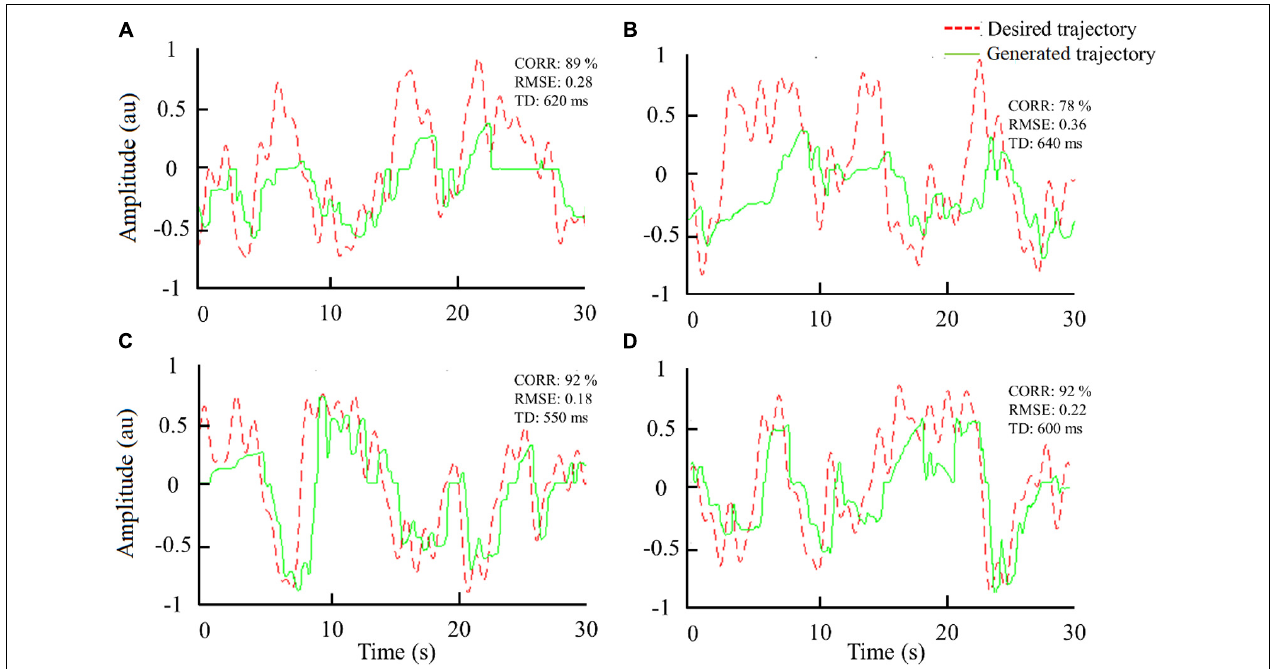
FIGURE 2 | Trajectories generated by one subject during tracking using surface [ (A) trial 1 and (C) trial 8] and subdermal stimulation [ (B) trial 1 and (D) trial 8]. Notation: RMSE, root mean square error; CORR, correlation; TD, time